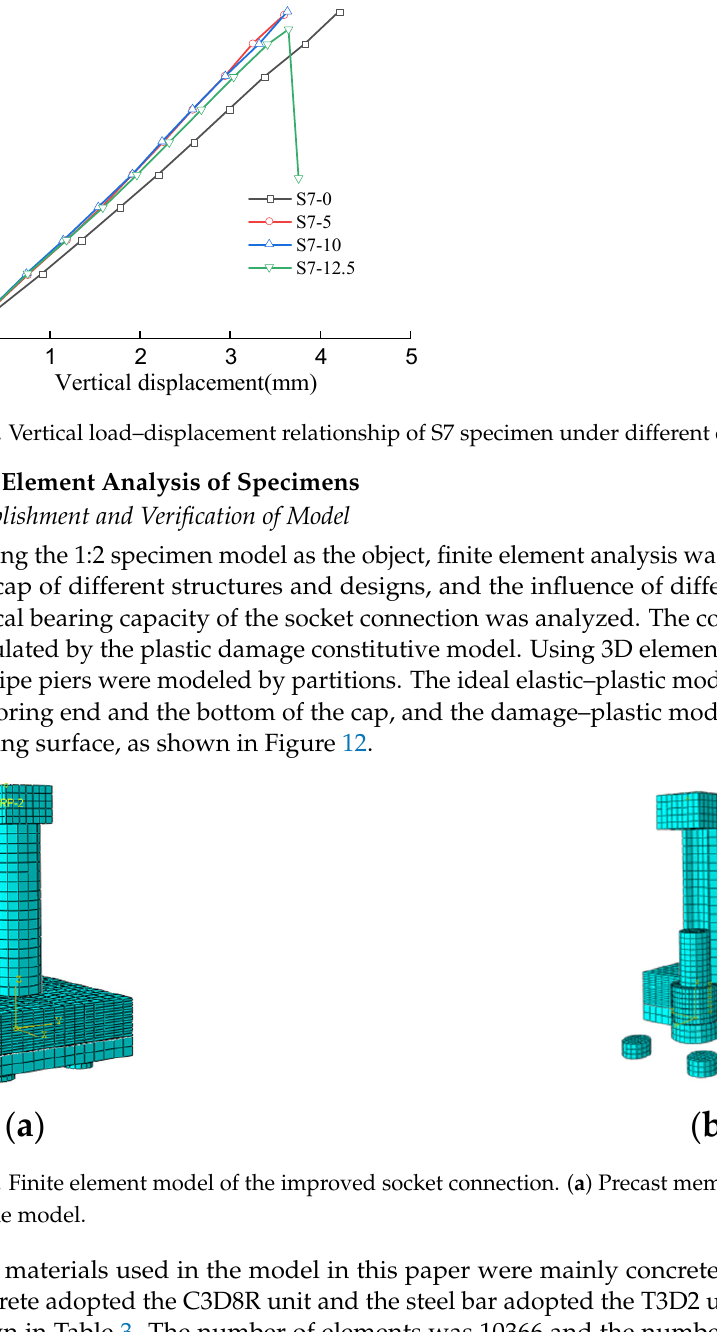
Table 3. Material properties of the structural model.